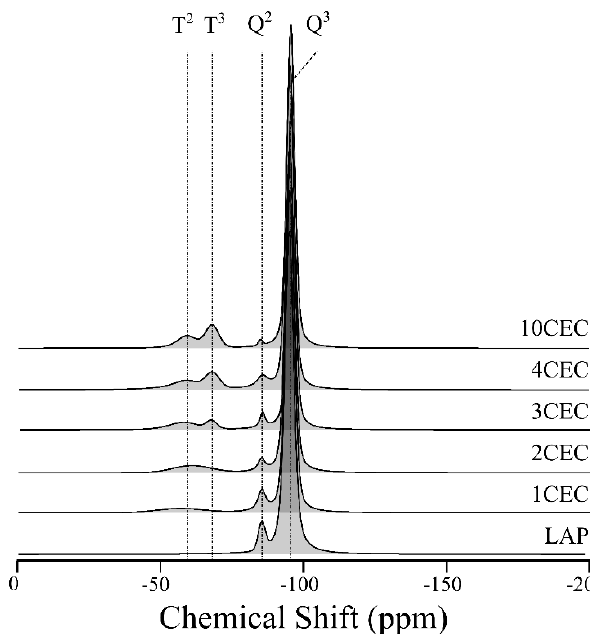
Figure 3. Solid-state 29 Si NMR spectra of LAP and LAP-APTES for different loads of APTES. Table 1. Ratios obtained from the deconvolution of 29 Si NMR spectra.